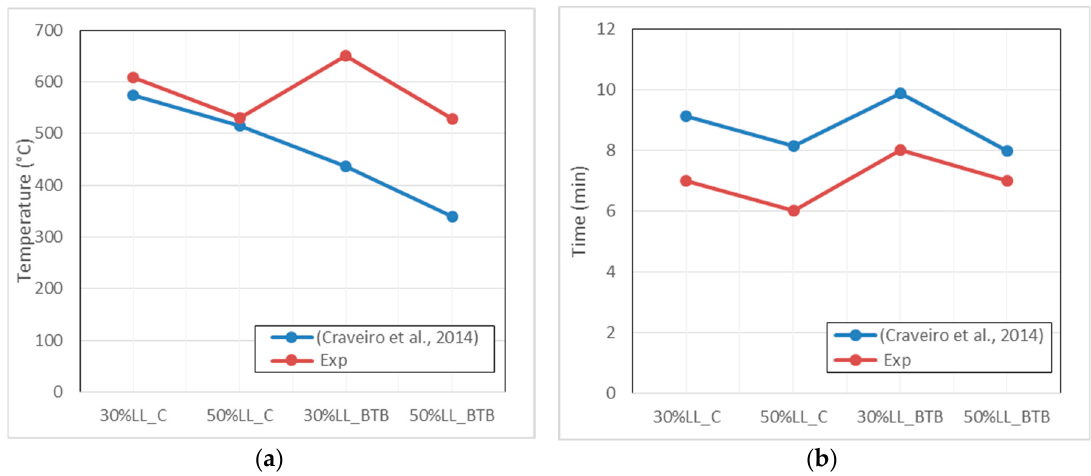
Figure 12. Comparison of the ( a ) temperature and ( b ) time with previous research.